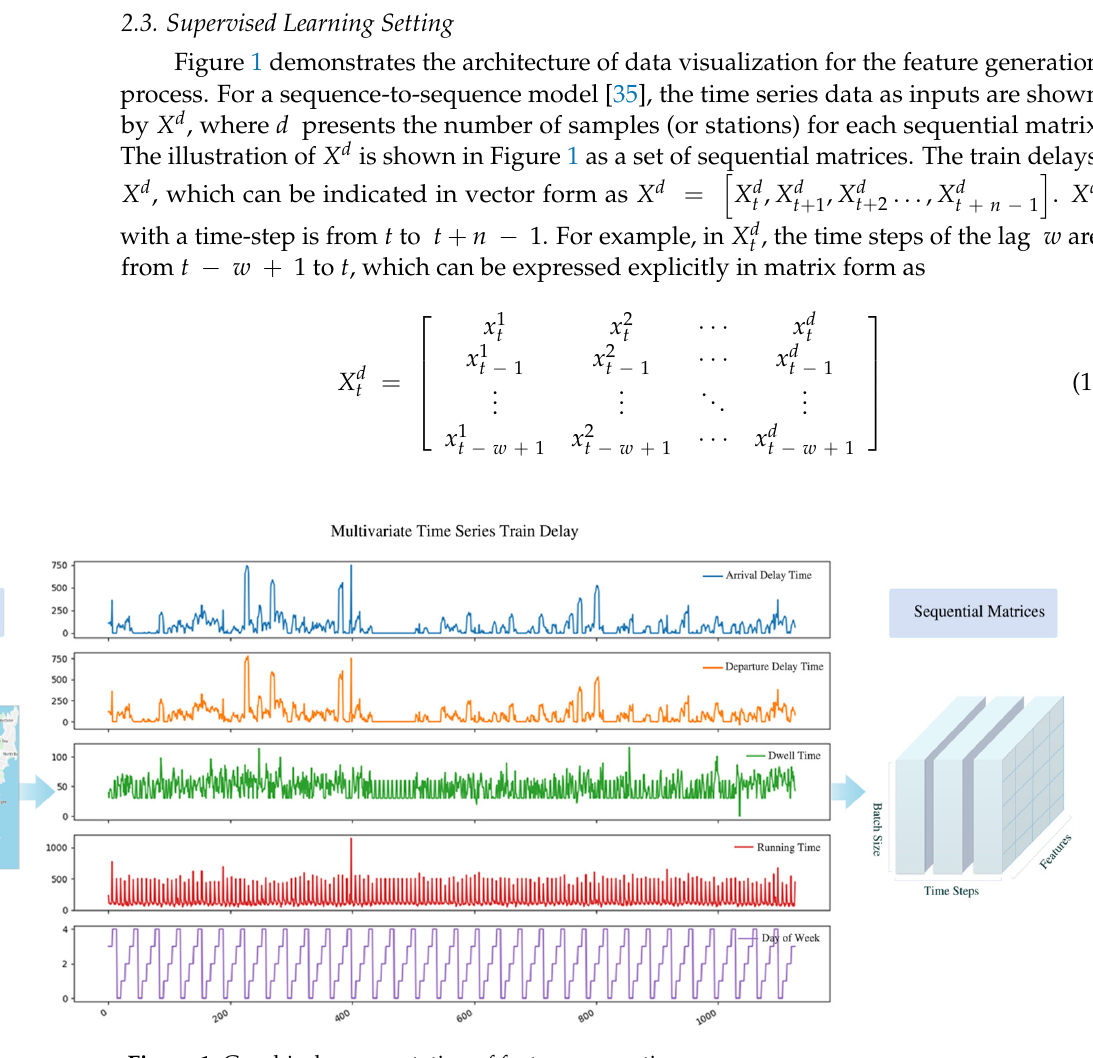
Figure 1. Graphical representation of feature generation process.